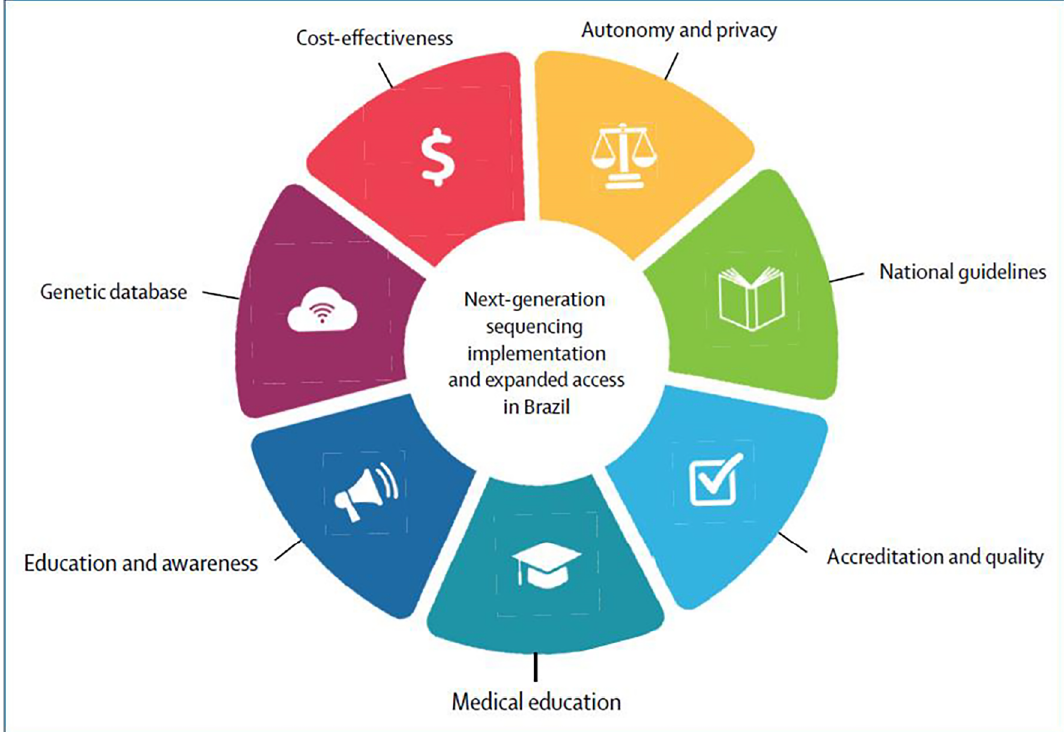
Figure 4. Actions needed to expand NGS adoption in Brazil, according to Santos et al. (2019). [16]